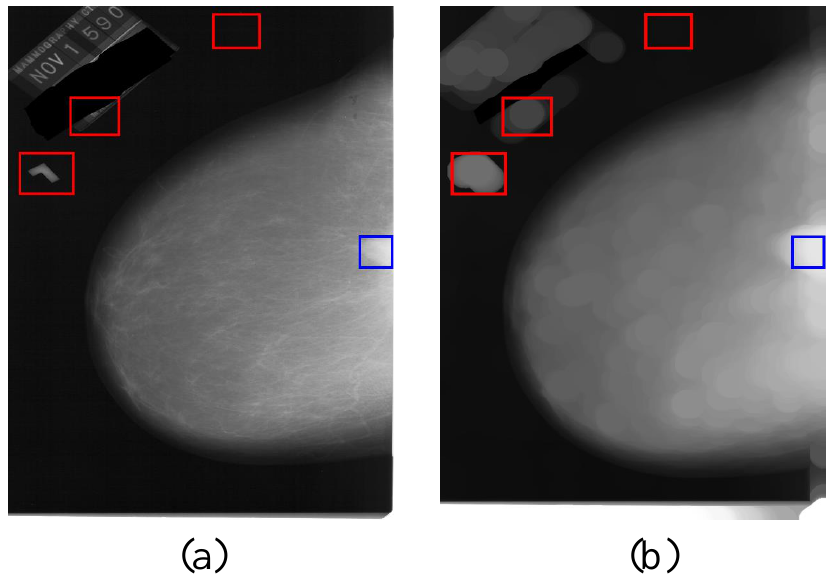
Figure 11. The mismatched breast mass. Where ( a ) is the mammographic image, ( b ) is the processed image of ( a ) by the mathematical morphology and image template matching